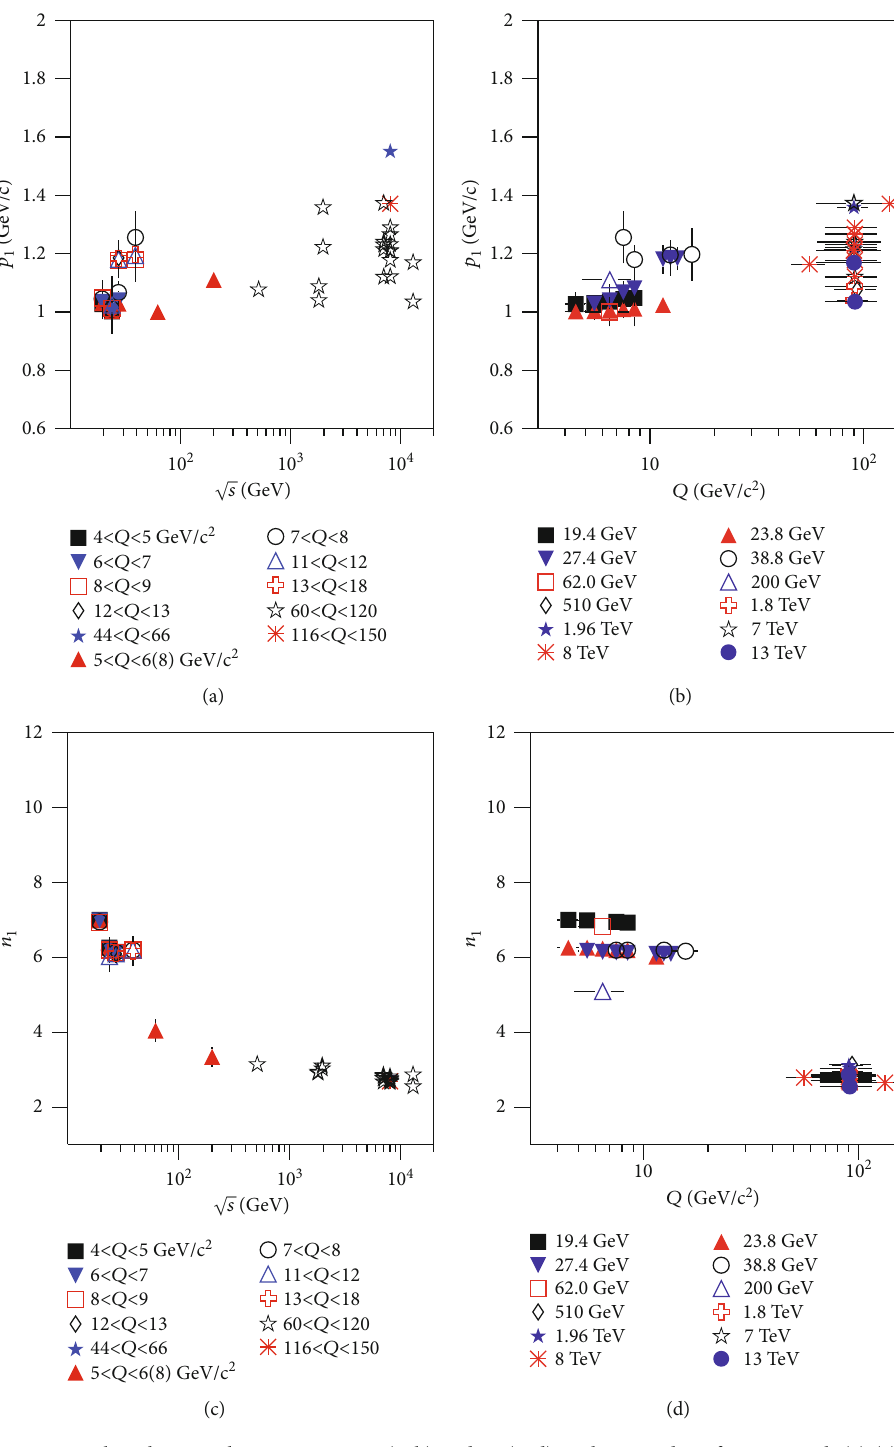
n 1 (c, d) in the Hagedorn function with (a) (c) 1 (a, b) and